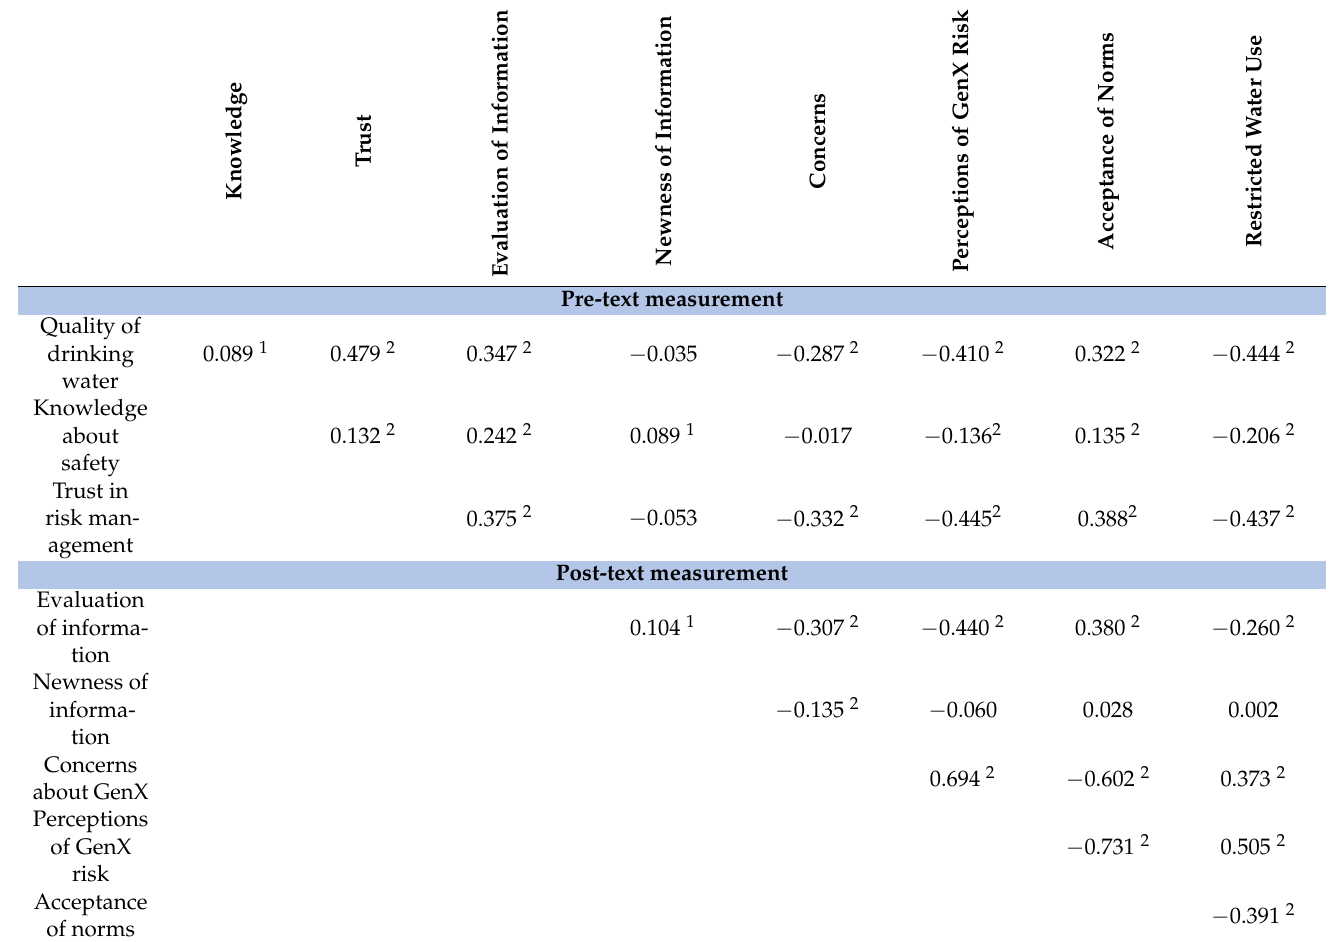
Table 4. Associations between outcome